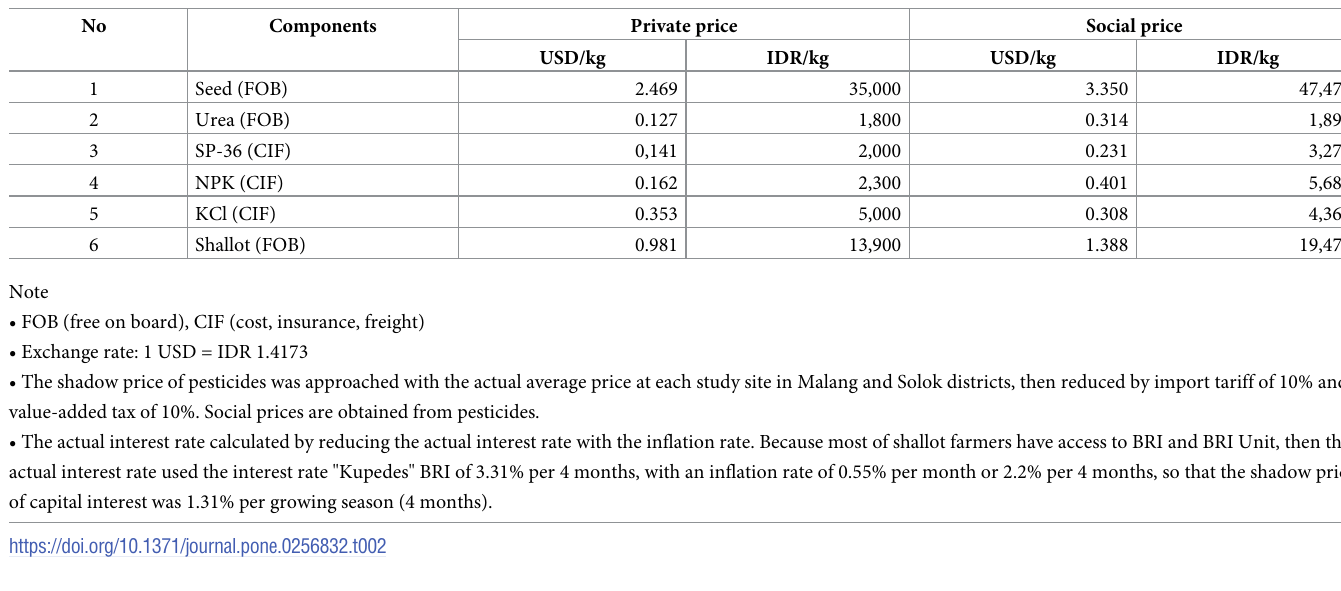
Table 2. Social price for tradable